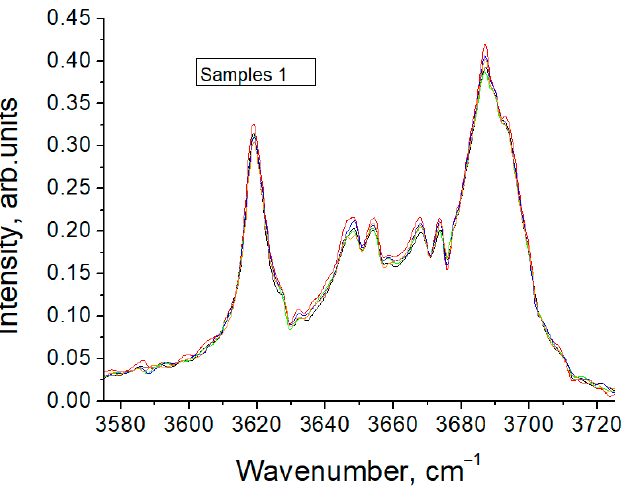
Figure 2. Regions of the spectra of five independently prepared samples of dry kaolinite. The spectra are normalized so that their intensities coincide at point “a” with a wavenumber of 1005 cm − 1 of the spectra of five independently prepared samples of dry kaolinite after intensity normalization at point “a” (Figure 1).